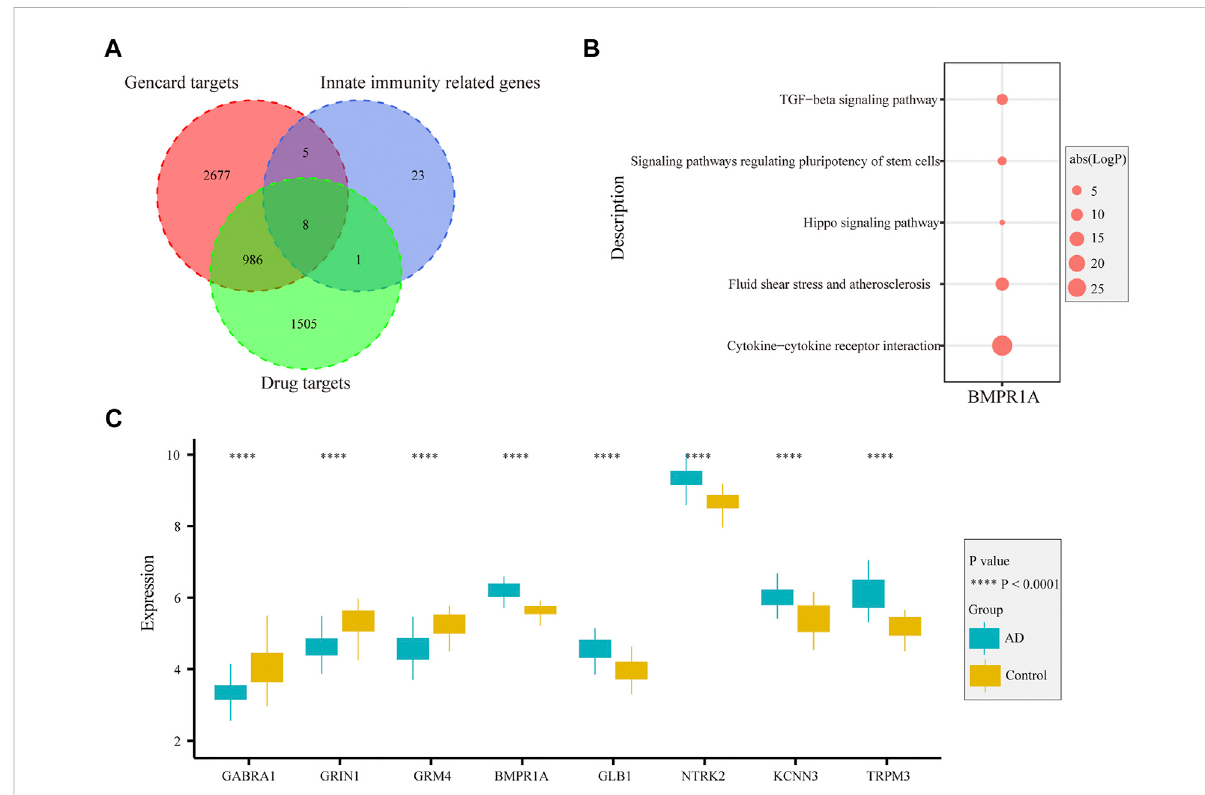
FIGURE 6 Function and expression of drug-targeted genes associated with myeloid cells in AD. (A) . Eight drug-targeted genes associated with myeloid cells for AD were selected. (B) . Pathways from KEGG analysis with 81 irDEGs associated with drug-targeted genes. (C) . Boxplot displaying the expression of eight drug-targeted genes in the entorhinal cortex between AD and control samples: GABRA1 , GRIN1 , and GRM4 are signi fi cantly increased in AD samples, whereas BMPR1A , GLB1 , NTRK2 , KCNN3 , and TRPM3 are decreased in AD